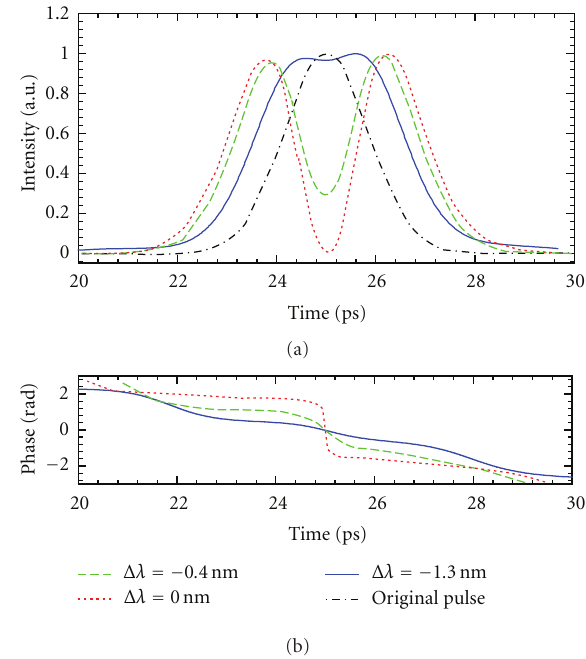
Figure 4: Experimentally generated intensity (a) and phase (b) temporal profiles of the synthesized waveforms at the uniform LPG output when a 1.8 ps input pulse is launched at the input for di ff erent input pulse-LPG wavelength detuning ( Δ λ )